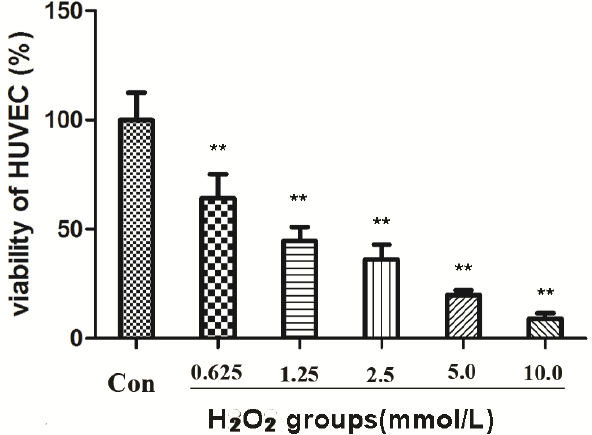
O on viability of HUVECs ( ** p < 0.01 vs. control). 2 2